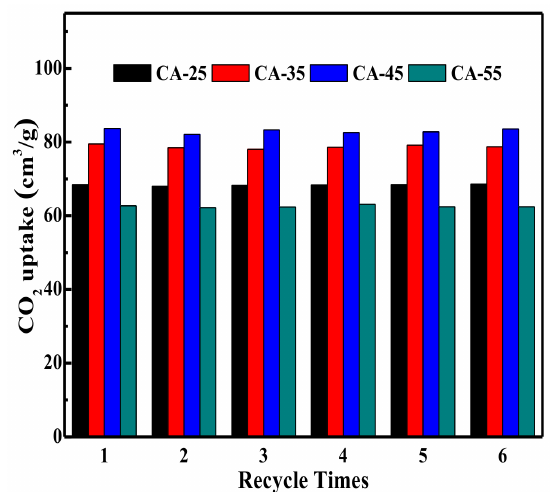
Figure 9. Adsorption isotherms of CO 2 over CA-X samples at 1 bar and 0 ◦ C.